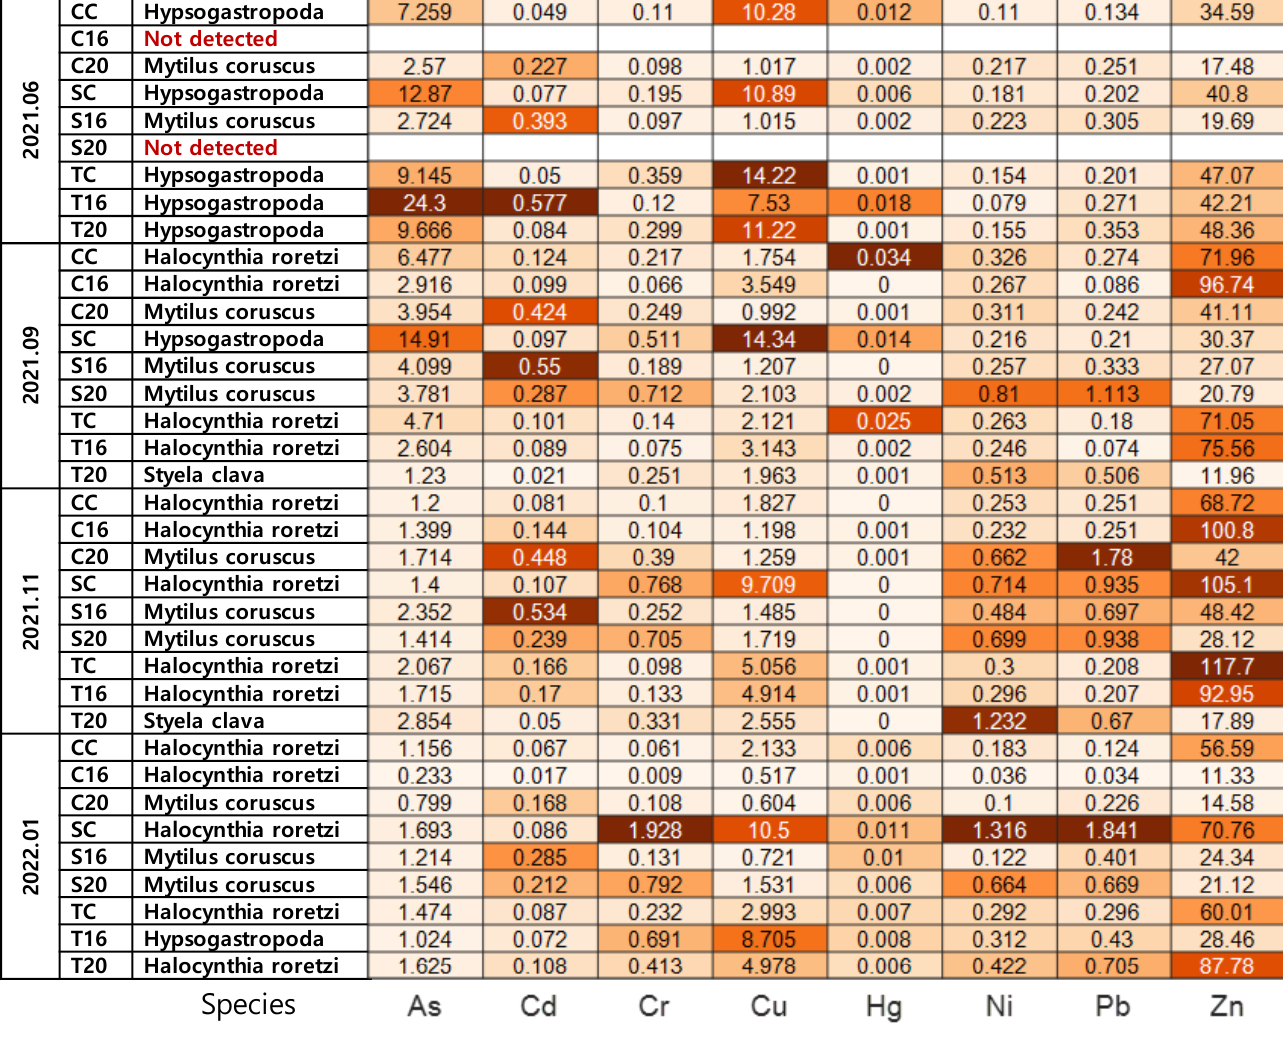
Figure 3. Heat map of the concentrations of heavy metals in marine organisms attached to the natural rock (control case) and artificial reefs.